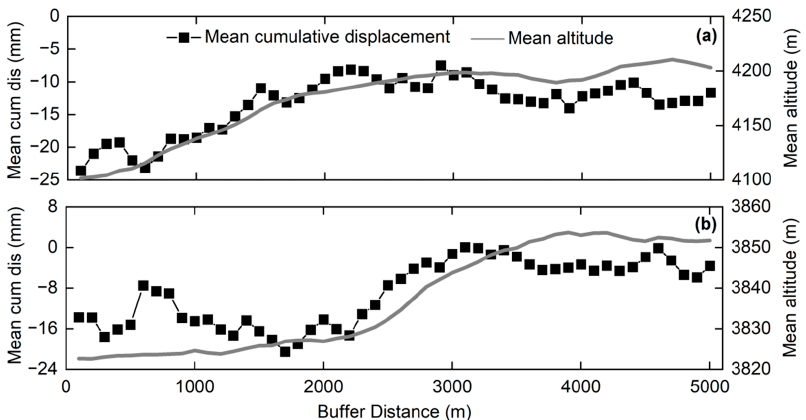
Figure 6. Mean cumulative displacement and elevation change curve of buffer gradient outside the mining area from January 2018 to December 2020. ( a , b ) JHG and JC mining areas, respectively. Notes: Mean cum dis: Mean cumulative displacement.